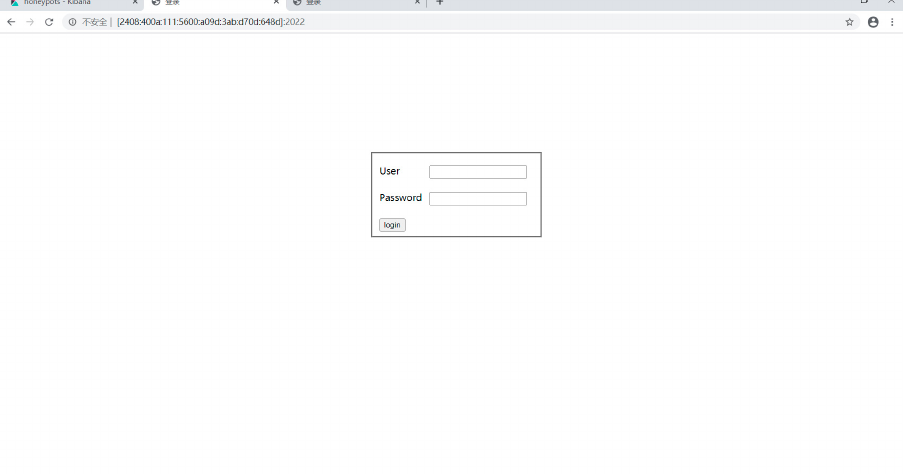
Figure 4. A weak password application website. Information 2020 , 11 , x FOR PEER REVIEW